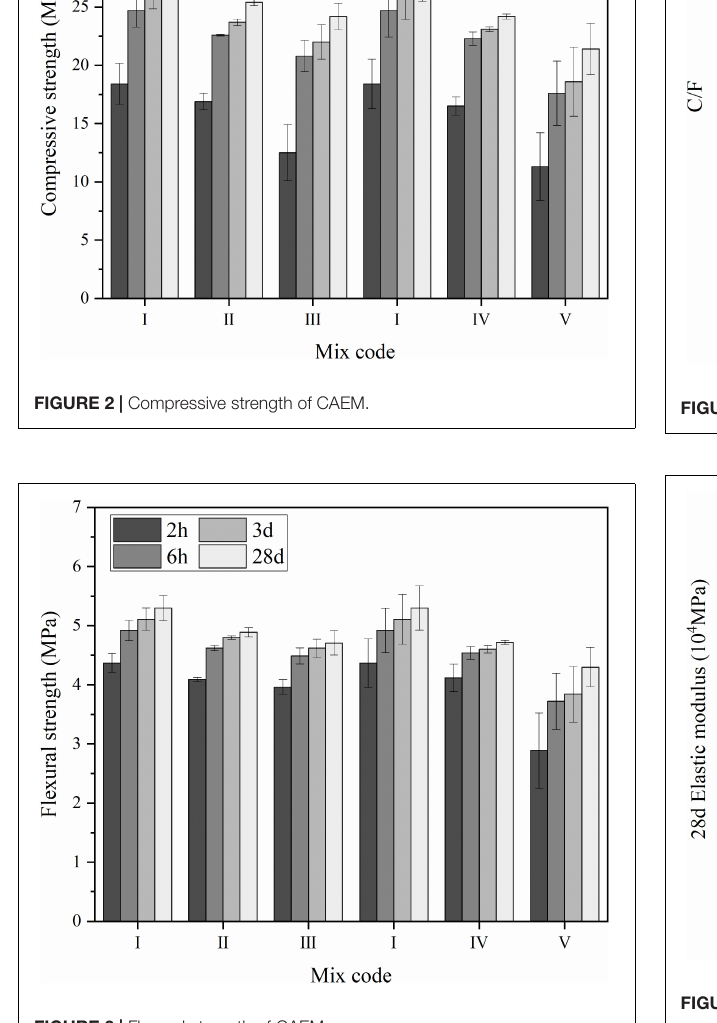
FIGURE 3 | Flexural strength of CAEM.